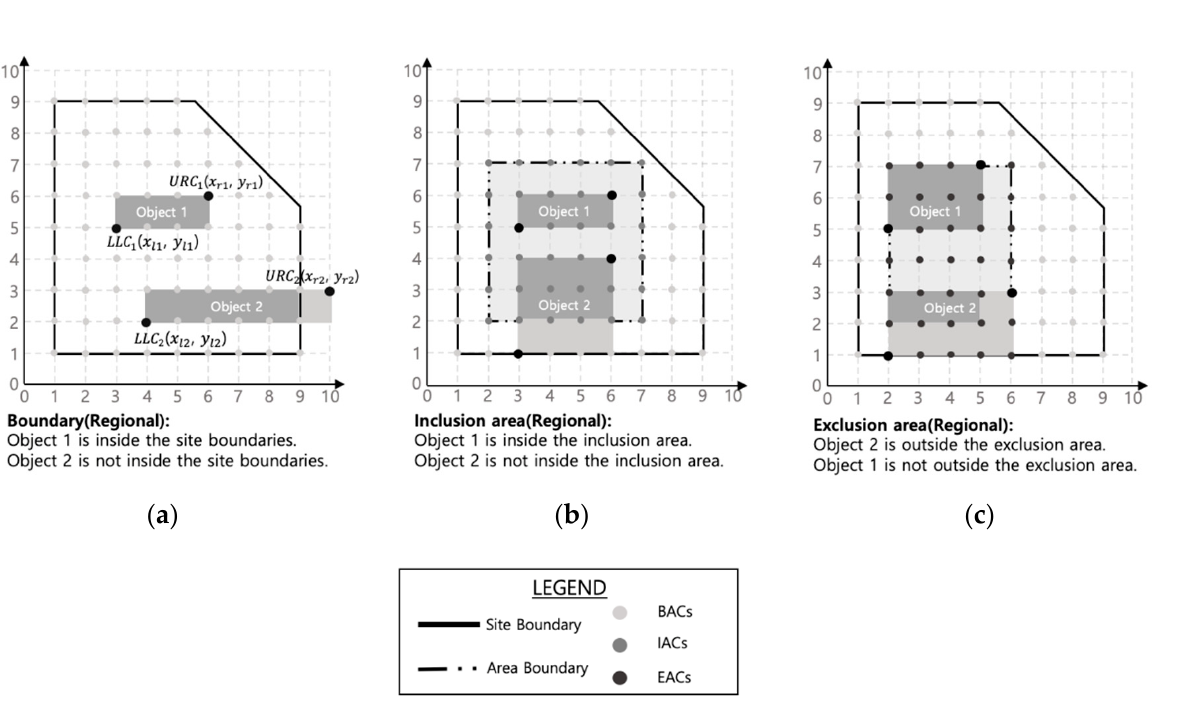
Figure 5. Regional constraint: boundary ( a ), inclusion area ( b ), and exclusion area ( c ) constraints.